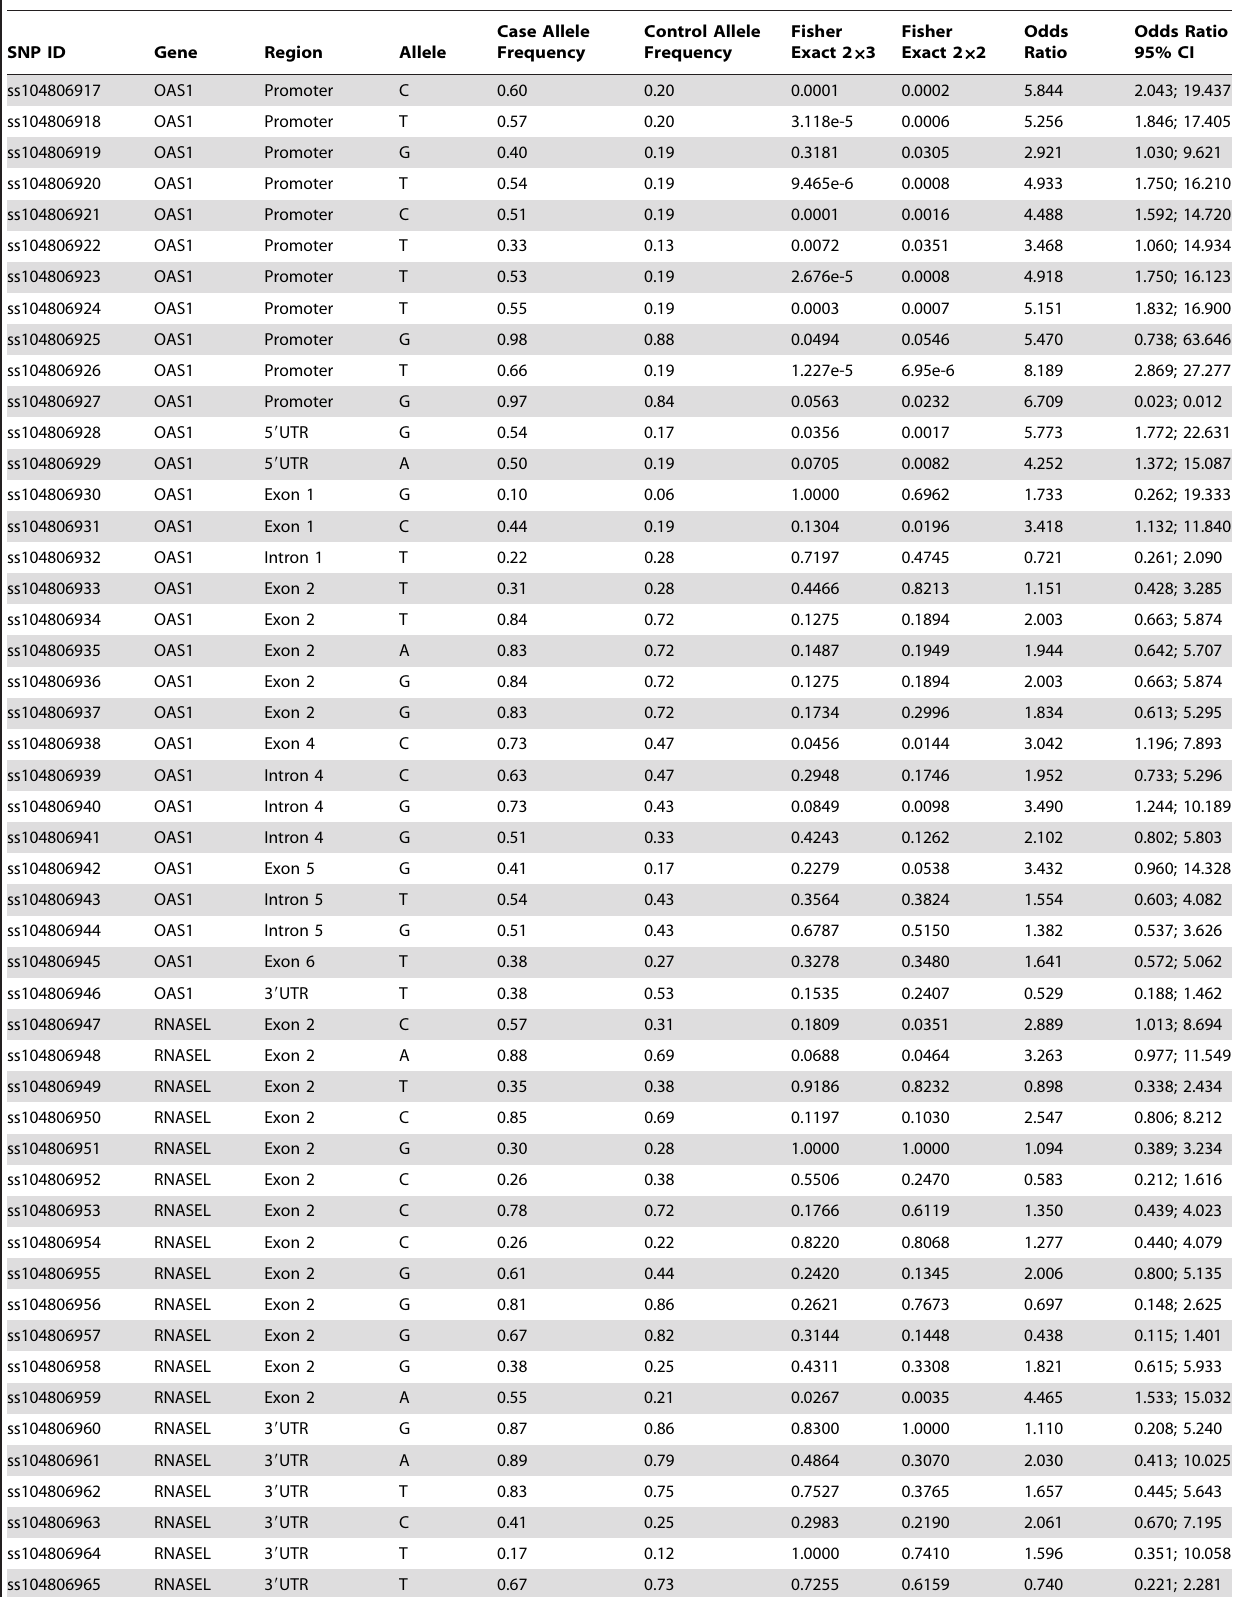
Table 1. Statistical association of single nucleotide polymorphisms to West Nile